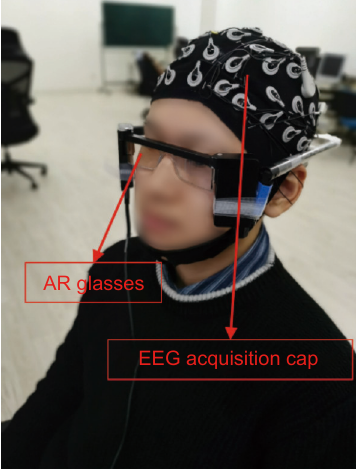
Fig. 4 Experimental setup for subjects. Fig. 5 Human-in-the-loop multi-robot experimental